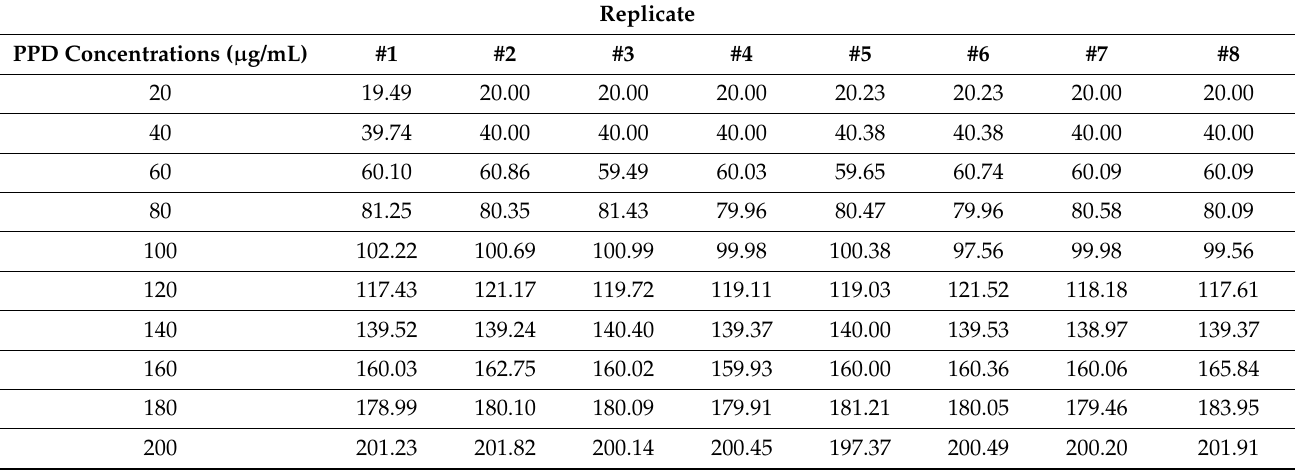
Table 1. Calibration data in terms of PPD concentrations ( µ